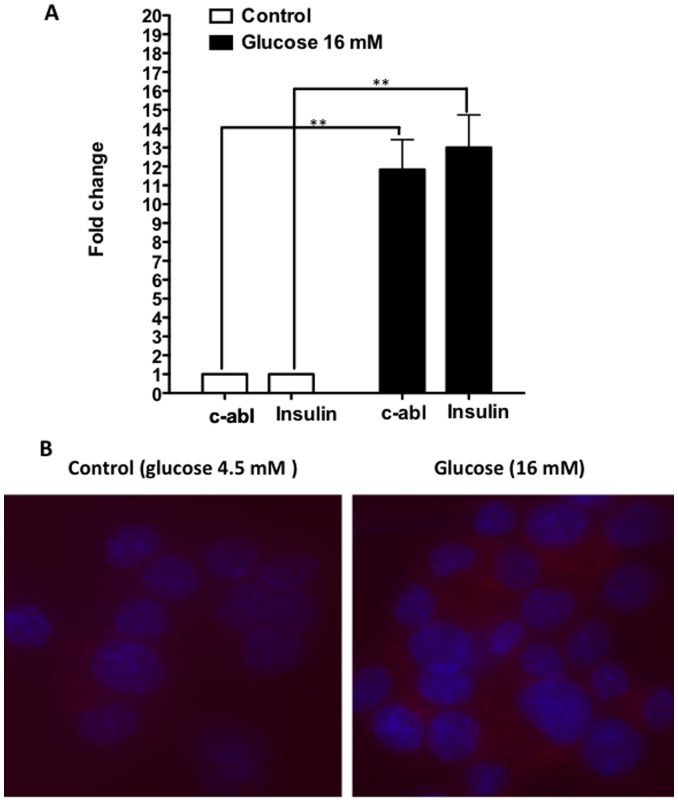
Glucose stimulation induces up-regulation of both c-Abl and insulin expression.
A . NIT-1 cells were cultured in low glucose DMEM medium with or without glucose 16 mM for 6 hrs. Thereafter, the cells were examined for c-Abl and insulin gene expression using real-time RT-PCR. Student t test was performed. The results shown were from a representative of 3 independent experiments. *: p>0.05, **:p<0.001. B. NIT-1 cells were cultured in low glucose DMEM medium with or without glucose 16 mM for 24 hrs. Then, the cells were cytospun onto slides and stained with anti-c-Abl antibodies and Dappi, and visualized by a fluorescent microscope (Zeiss Axioskop). A representative image of three slides in each group is shown.